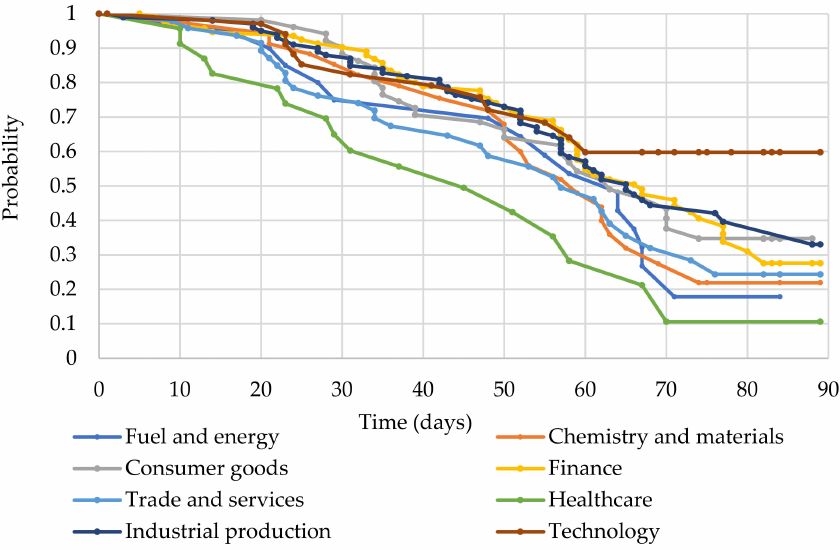
Figure 3. Kaplan-Meier estimators for macro sectors on the Warsaw Stock Exchange. Source: own elaboration on the basis of data from https://www.gpw.pl [73] (accessed on 19 June